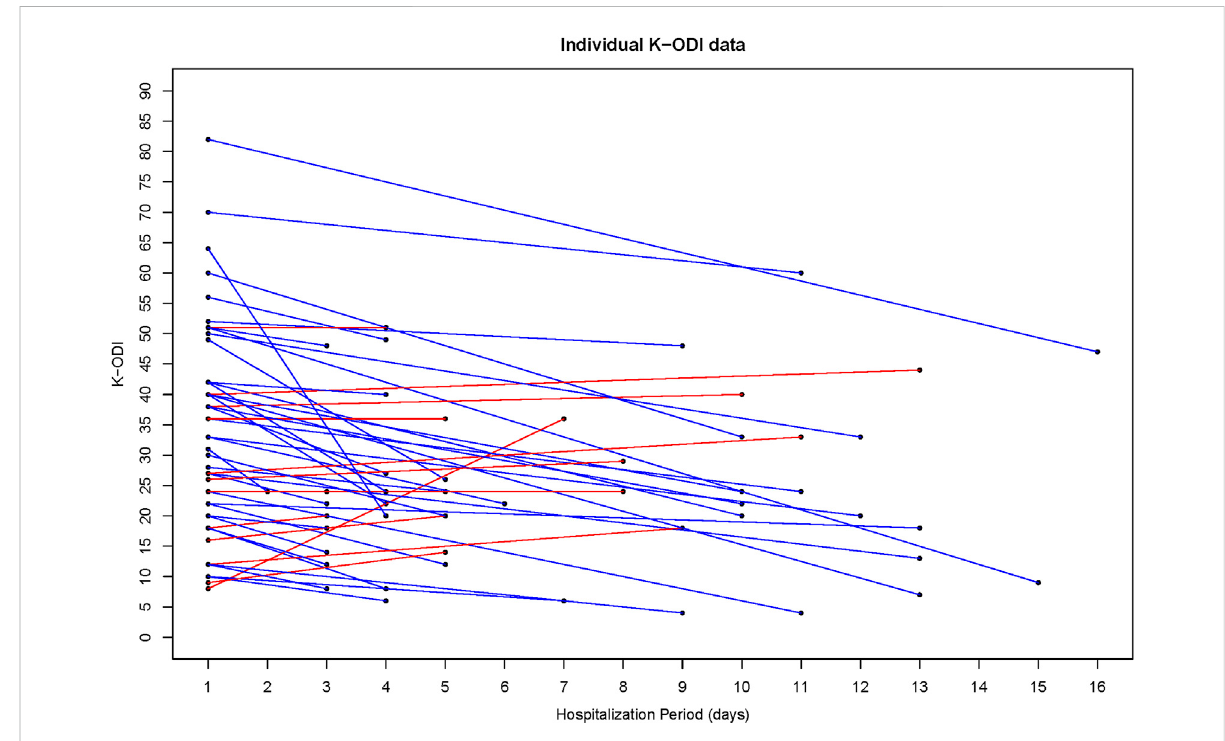
FIGURE 3 Individual Data of the Korean version of the Oswestry Disability Index